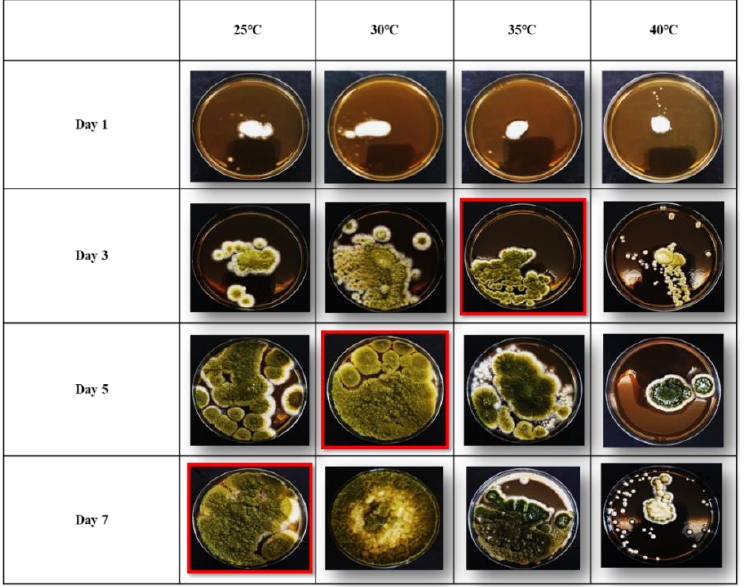
Figure 1. Diametric growth rates (mm/d) of AKR5 − strain cultivated on malt extract agar (MEA) at four different temperatures (25, 30, 35, and 40 °C) for seven days.